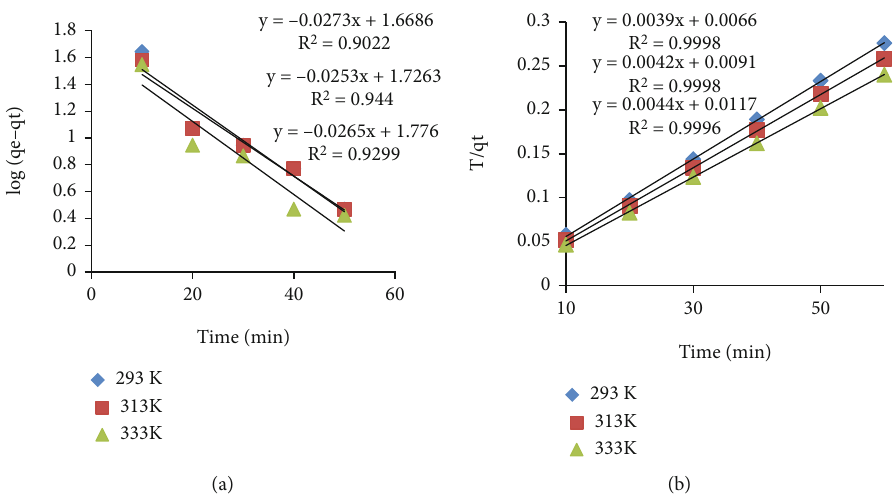
Figure 8: Kinetics of toluidine adsorption on the GA/AM (adsorbent 0.01, dye solution 10 mL, pH 11, temp 313K, time 60min): (a) pseudo- 1 st -order plot and (b) pseudo-2 nd -order